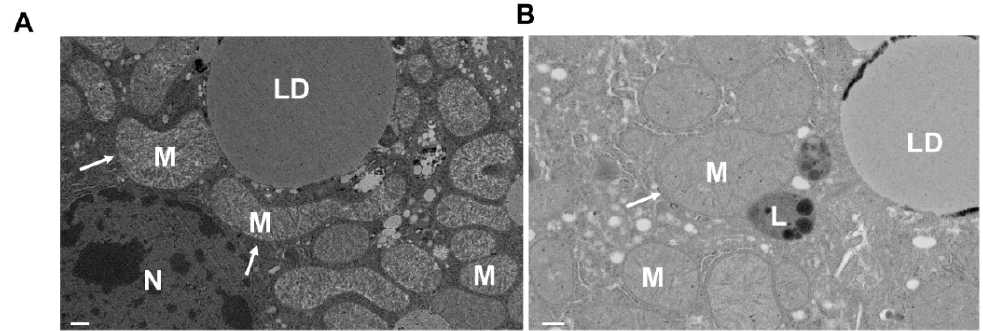
Figure 4. Megamitochondria in mouse livers after chronic plus binge alcohol feeding. Two three-month-old C57BL / 6 mice were subjected to the chronic-plus-binge (Gao-binge) alcohol model. Liver sections were fixed and electron microscopy followed ( A and B from Gao-binge alcohol-fed mouse livers). Arrows denote megamitochondria. L, lysosome; LD, lipid droplet; M, mitochondria; N, nucleus. Bar: 50 nm.